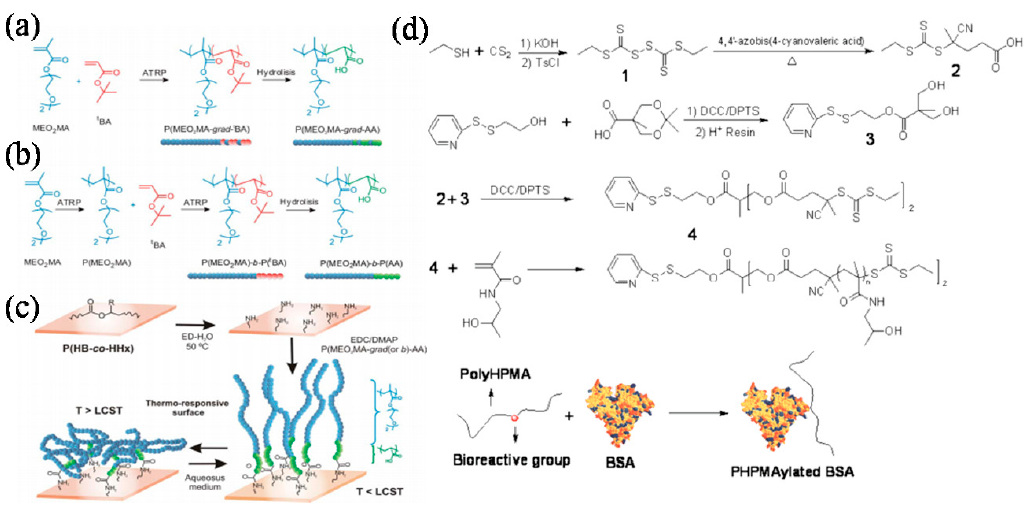
Figure 12. ( a ) Synthesis of the gradient copolymers; ( b ) Synthesis of the block copolymers; ( c